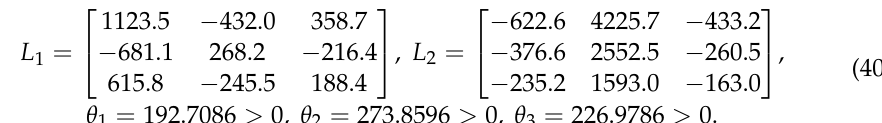
Moreover, in Figure 11, the red line denotes the state trajectory curve of Π (cid:107)X ( t ) (cid:107) 2 , the green line denotes 10 state trajectory curve of (cid:107)X ( t ) (cid:107) 2 , and the blue line denotes the curve of 2.6 (cid:107)X 0 (cid:107) 2 e − 0.5 t for the OBC case. As you can see from Figure 11, Π [ (cid:107)X ( t ) (cid:107) 2 |X 0 , η 0 ] <